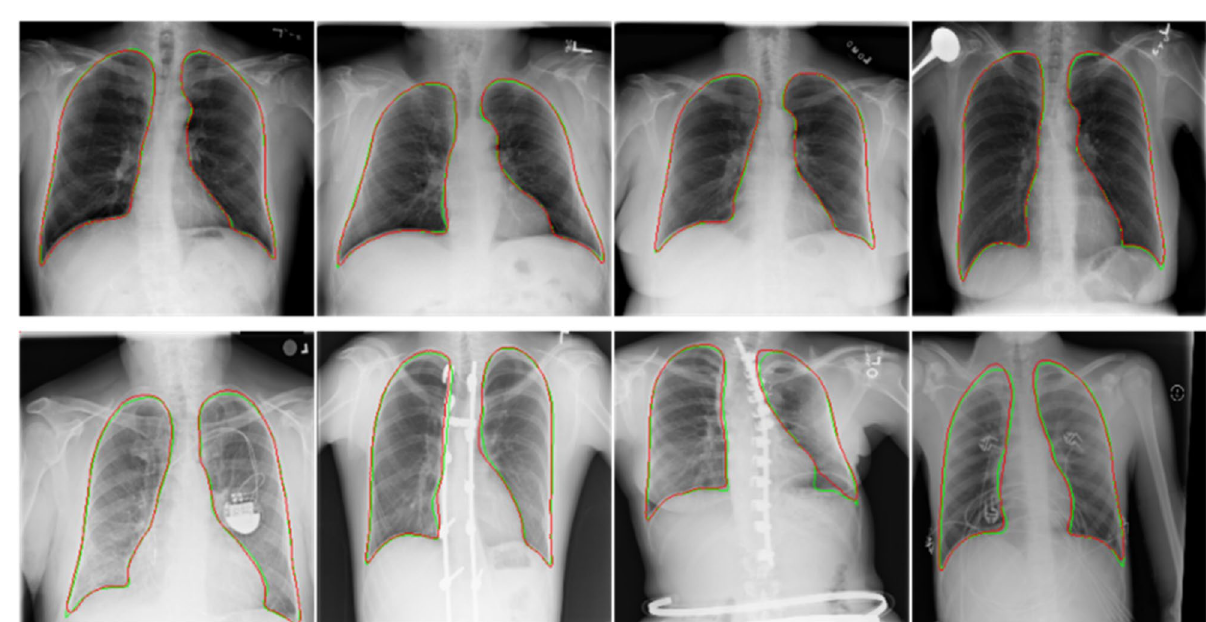
Figure 6. As shown in the figure above, we comprehensively evaluated the Haut dataset. Green represents the real lung field and red represents the lung field predicted by the model. The first line belongs to healthy or mild symptoms, and the effect of lung segmentation is very good. The second line is that foreign bodies (various medical devices) block the lung field, and the segmentation effect is relatively poor.